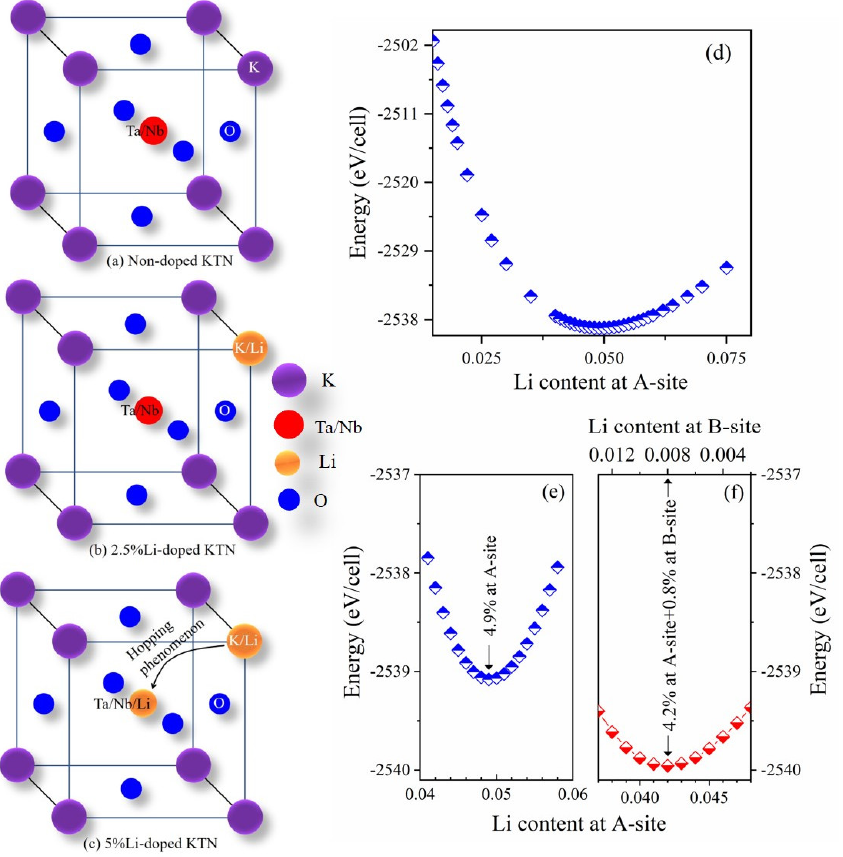
Figure 8. A schematic illustration of the lattice showing the location of substituents in the cubic perovskite, ( a ) non-doped KTN, ( b ) 2.5%Li-doped KTN, and ( c ) 5%Li-doped KTN single crystals, where a small percentage of Li ions occupy the B-site in 5%Li-doped KTN and the Li ions only occupy the A-site in 2.5%Li-doped KTN. The total energy per formula unit obtained using the den- sity functional theory (DFT) calculation as a function of the Li content ( d ) at the A-site ( e ) near the 5%Li-doping at the A-site and ( f ) at A- and B-sites of the Li-doped KTN/0.27 single crystal. The data were adapted from Ref.